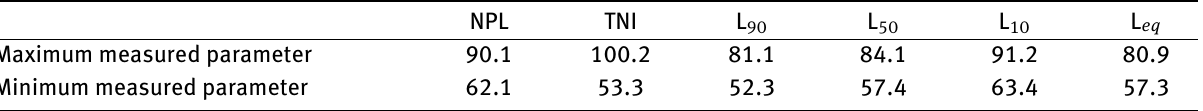
Table 1: Minimum and maximum sound indices measured at 20 stations